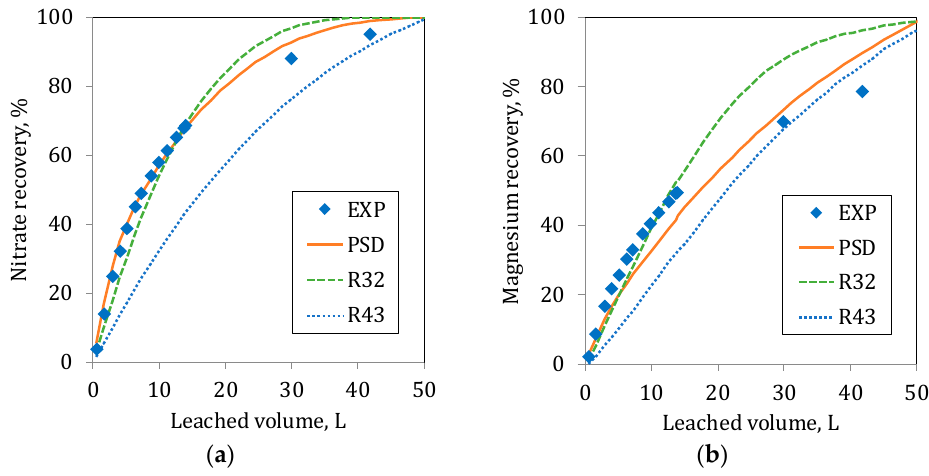
Figure 10. Simulated recoveries for column C80. ( a ) Nitrate and ( b ) Magnesium, using the radii of Table 6. Markers represent the experimental data, the solid line is the Particle Size Distribution (PSD), the dashed line is R32 and the dotted line is R43.